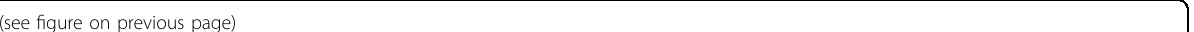
Fig. 1 GDF15 induces the LIF – STAT3 pathway and enhances glioma stem cell (GSC)-like phenotype in GSC-like cells. a qRT-PCR analysis of LIF expression in U87 TS cells treated with 0, 2, 10, or 20 ng/ml GDF15. b Immunoblotting analysis of the levels of p-STAT3, STAT3, LIF, and β -actin in U87 TS cells after treatment with 10 ng/ml GDF15 and 100 pM TGF- β . c Immunocytochemical analysis with anti-LIF and anti-p-STAT3 in U87 TS cells. Nuclei were counterstained with DAPI. Scale bar = 10 μ m. d , upper: Immunoblotting analysis of GDF15 expression after treatment of U87 TS cells with shRNA lentivirus targeting the GDF15 gene and control lentivirus. Lower: qRT-PCR analysis of GDF15 and LIF expression in U87 TS cells with short hairpin RNA lentivirus-mediated knockdown of GDF15. e Immunoblotting analysis of CD133, SOX2, and β -actin expression in U87 TS cells after treatment with GDF15 for 5 days. f Immunocytochemical analysis with anti-CD133 and anti-SOX2 in U87 TS cells. Nuclei were counterstained with DAPI. Scale bar = 10 μ m. g Effects of GDF15 on the sphere-forming capacity of U87 TS and G027 cells as determined by extreme limiting dilution assay ( n = 12). * P < 0.05; likelihood ratio test. h Representative images of U87 TS and G027 cells treated with 10 ng/ml GDF15 for 10 days. Scale bar = 100 μ m. i , j EdU incorporation in U87 TS cells treated with GDF15 for 4 days, followed by EdU for 24 h, and quanti fi cation of EdU-positive cells. Nuclei were counterstained with Hoechst stain. Scale bar = 100 μ m. k Immunoblotting analysis of CD133, SOX2, and β -actin expression in U87 TS cells after treatment with GDF15 and LIF-neutralizing antibodies (nAb) for 5 days. l The effects of LIF neutralization on the GDF15-induced sphere-forming frequency of U87 TS cells based on extreme limiting dilution assay ( n = 12). ** P < 0.005, *** P < 0.0005; likelihood ratio test. m Cell division was determined by the EdU incorporation assay in U87 TS cells treated with GDF15 and anti-LIF-neutralizing antibodies. Values in a , d , j , and m are from three independent experiments and expressed as mean ± s.e.m. * P < 0.05, ** P < 0.005, *** P < 0.0005. Unpaired t test ( a , d , j ); one-way ANOVA with Tukey ’ s multiple comparison test ( m ).